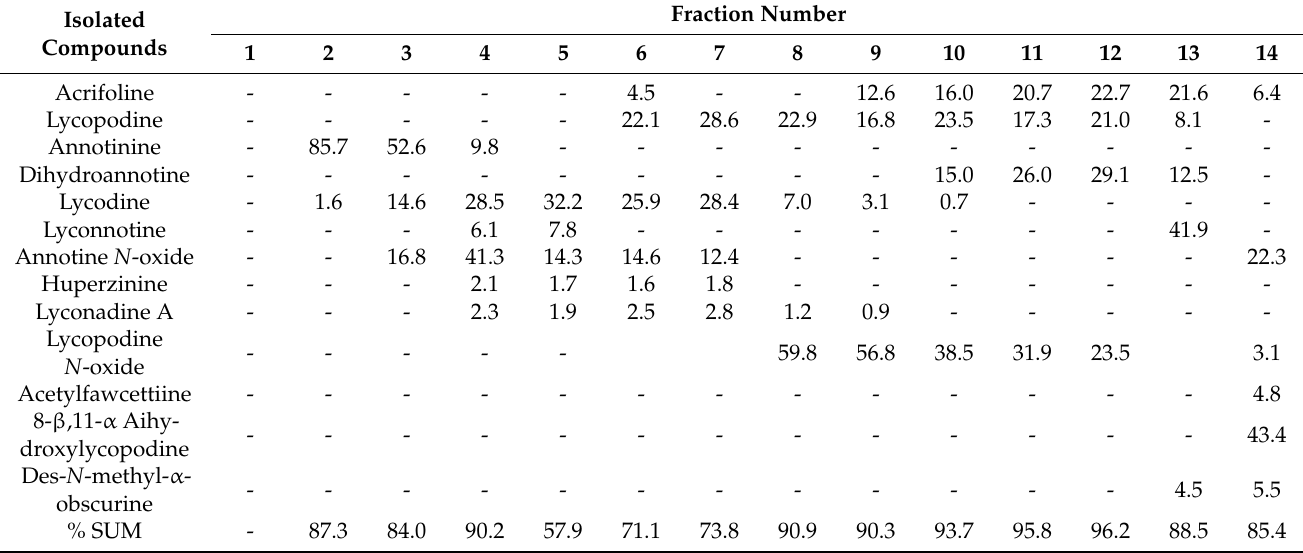
Table 2. Results of the alkaloids identified via HPLC/ESI-QTOF-MS present in fractions 1-14 obtained from experiment 1 via VLC using sorbents Al 2 O 3 and silica gel in ratio 1:3 from L. annotinum extract. Isolated